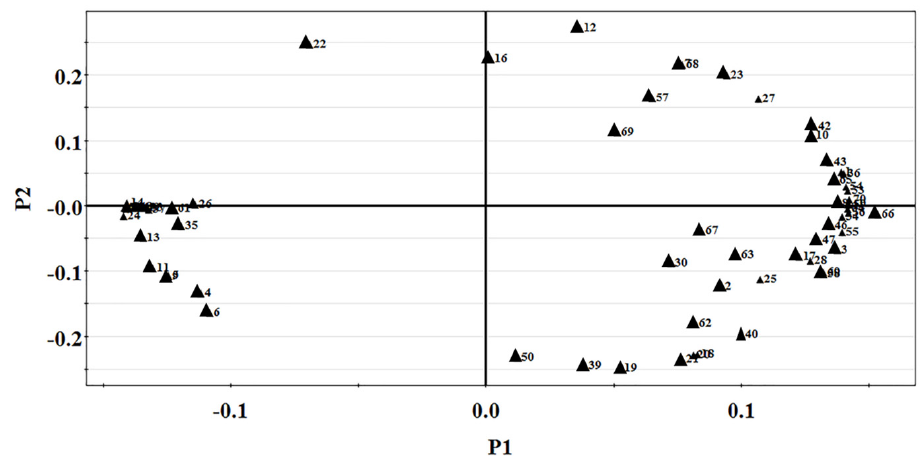
Figure 8. The PCA analysis load diagram of GC − MS of the SAEOs extracted by the four different methods.